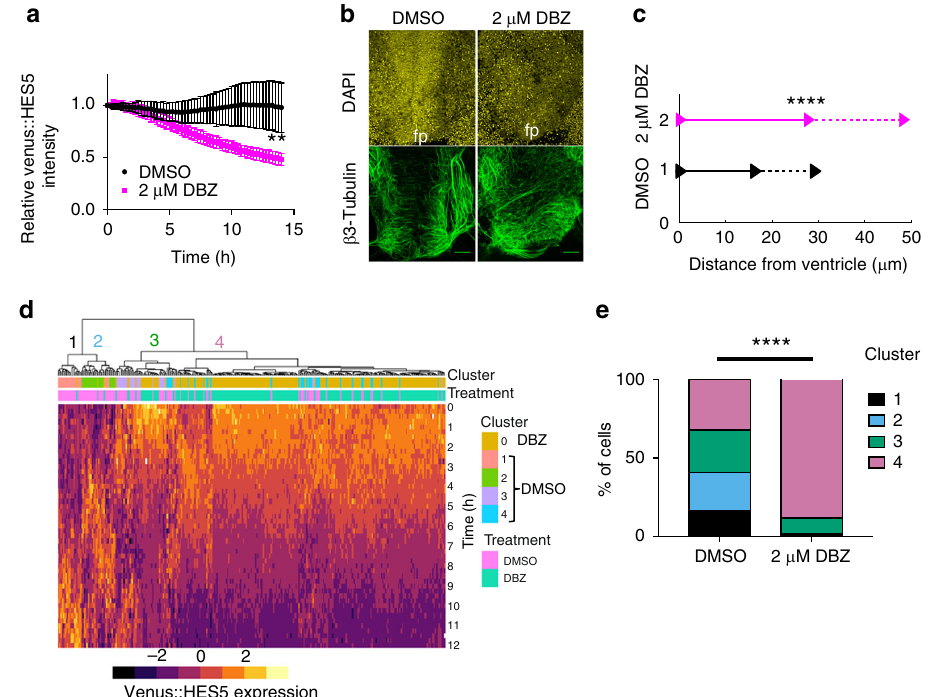
Fig. 4 Notch inhibition enriches for cluster 4-type Venus::HES5 dynamics. a Relative Venus::HES5 intensity of E10.5 ex vivo slices cultured in control DMSO (black) or 2 μ M DBZ (pink). Error bars — SD (three experiments). Endpoint intensity — Mann – Whitney two-tailed test p = 0.0095 (**). b β -III tubulin (early neuronal marker) staining of DMSO or 2 μ M DBZ-treated E10.5 ex vivo slices. fp fl oorplate. Scale bar 70 μ m. c Displacement of single cells away from ventricle in apico-basal axis in control DMSO or 2 μ M DBZ-treated E10.5 slices. Bold line — average, dashed line — SD from three experiments. Two-tailed t -test p < 0.0001 (****). d Hierarchical clustering of standardized single-cell Venus::HES5 expression in DMSO and 2 μ M DBZ-treated E10.5 ex vivo slices. Columns show standardised individual cell Venus::HES5 expression dynamics in a heatmap. Rows represent time points after start of individual cell tracking. Cells tracked for 12-h time window with 15-min frame intervals. 295 cells, three experiments clustered together. Cluster labels de fi ned using clustering of DMSO alone. Pink — DMSO cells, green — DBZ cells. e Percentage of cells in each cluster in DMSO and 2 μ M DBZ-treated E10.5 ex vivo slices. Frequency data subject to Chi-squared test showed p < 0.0001 (****). DMSO n = 100 cells, 2 μ M DBZ n = 195 cells, three experiments. Source data